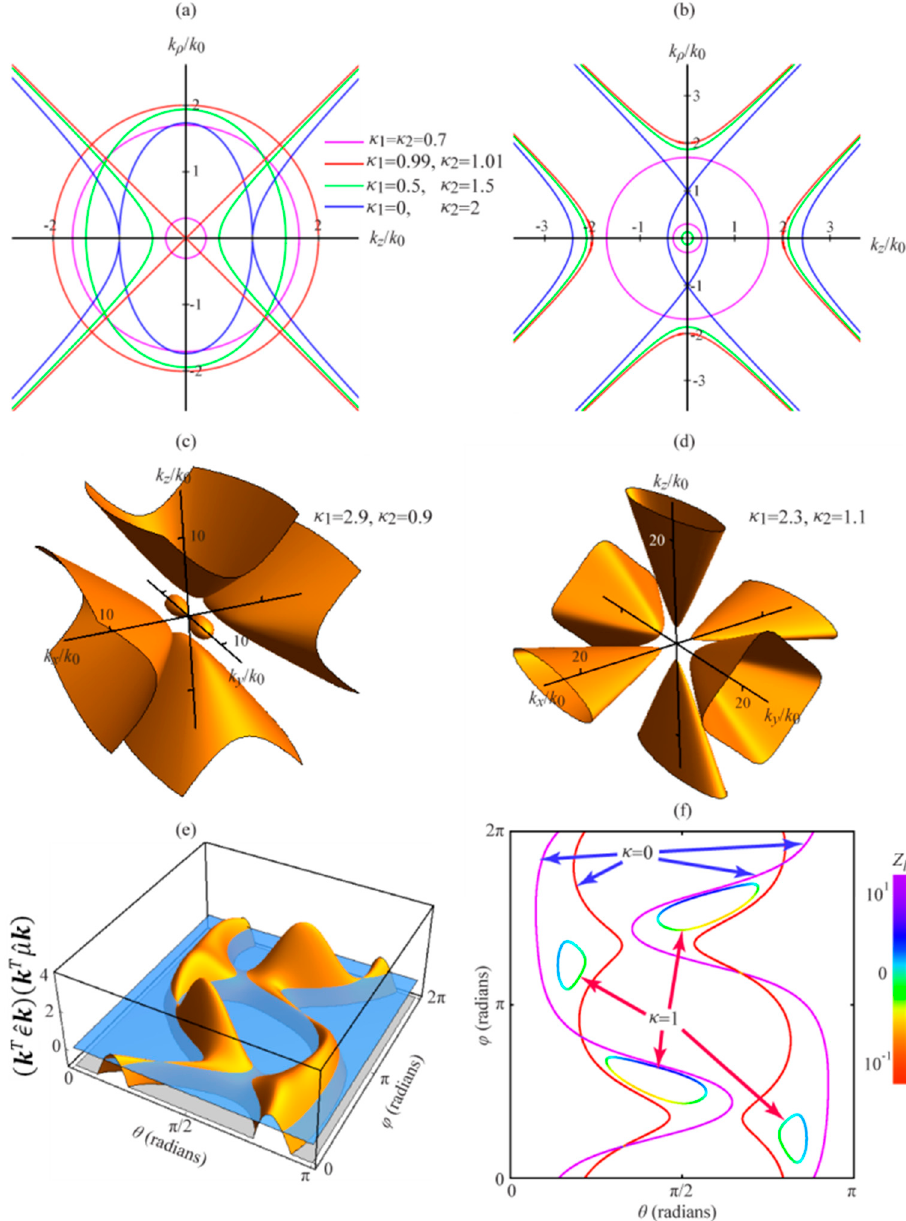
Figure 2. ( a – d ) Chirality-inducing hyperbolicity in nonhyperbolic phases (material parameters detailed in text). ( e , f ) Chirality-induced phase modifications in anisotropic materials. ( e ) Plot of the function (cid:4666)𝒌 (cid:3021) 𝜖̂𝒌(cid:4667)(cid:4666)𝒌 (cid:3021) 𝜇̂𝒌(cid:4667) for the 𝜖̂, 𝜇̂ matrices used in (f) and Figure 3.